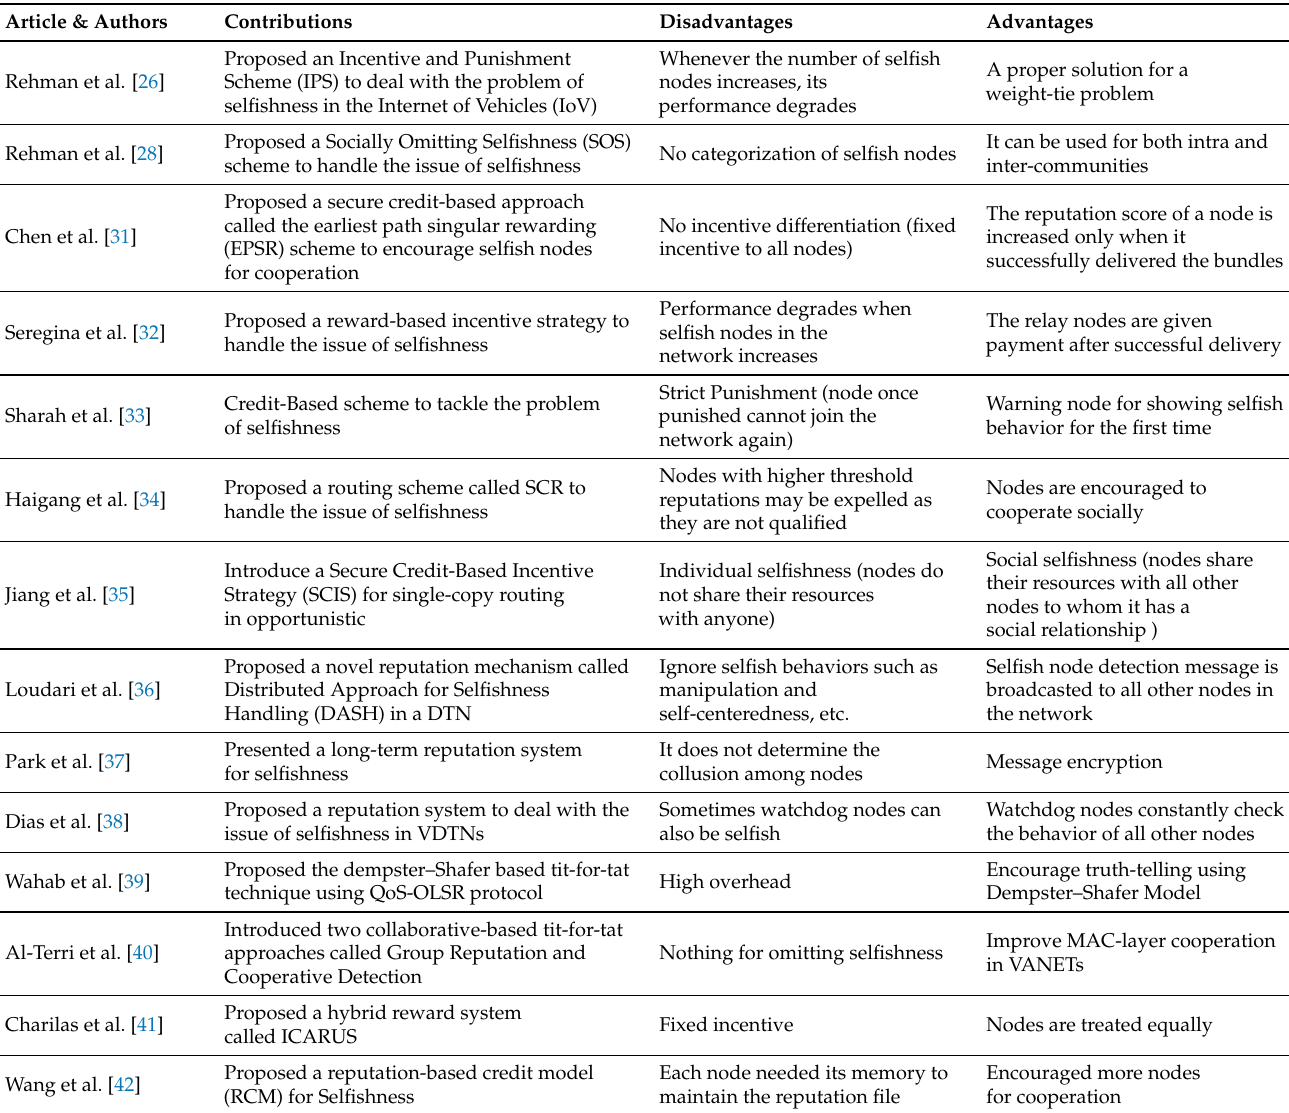
Table 1. Summary of all the strategies used in related